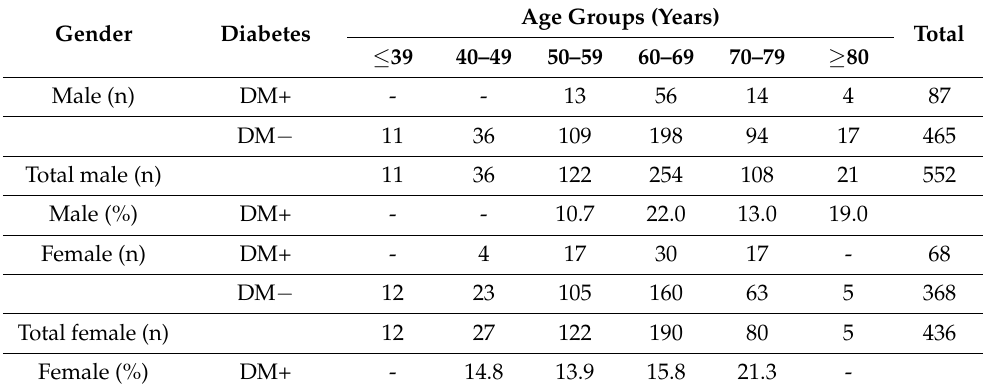
Table 1. Lines of chemotherapy by gender and age in patients both with and without DM.